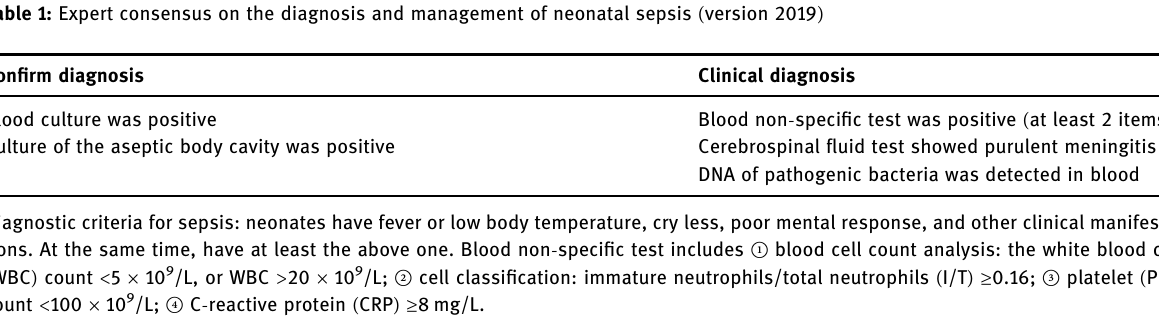
Table 1: Expert consensus on the diagnosis and management of neonatal sepsis ( version 2019 )